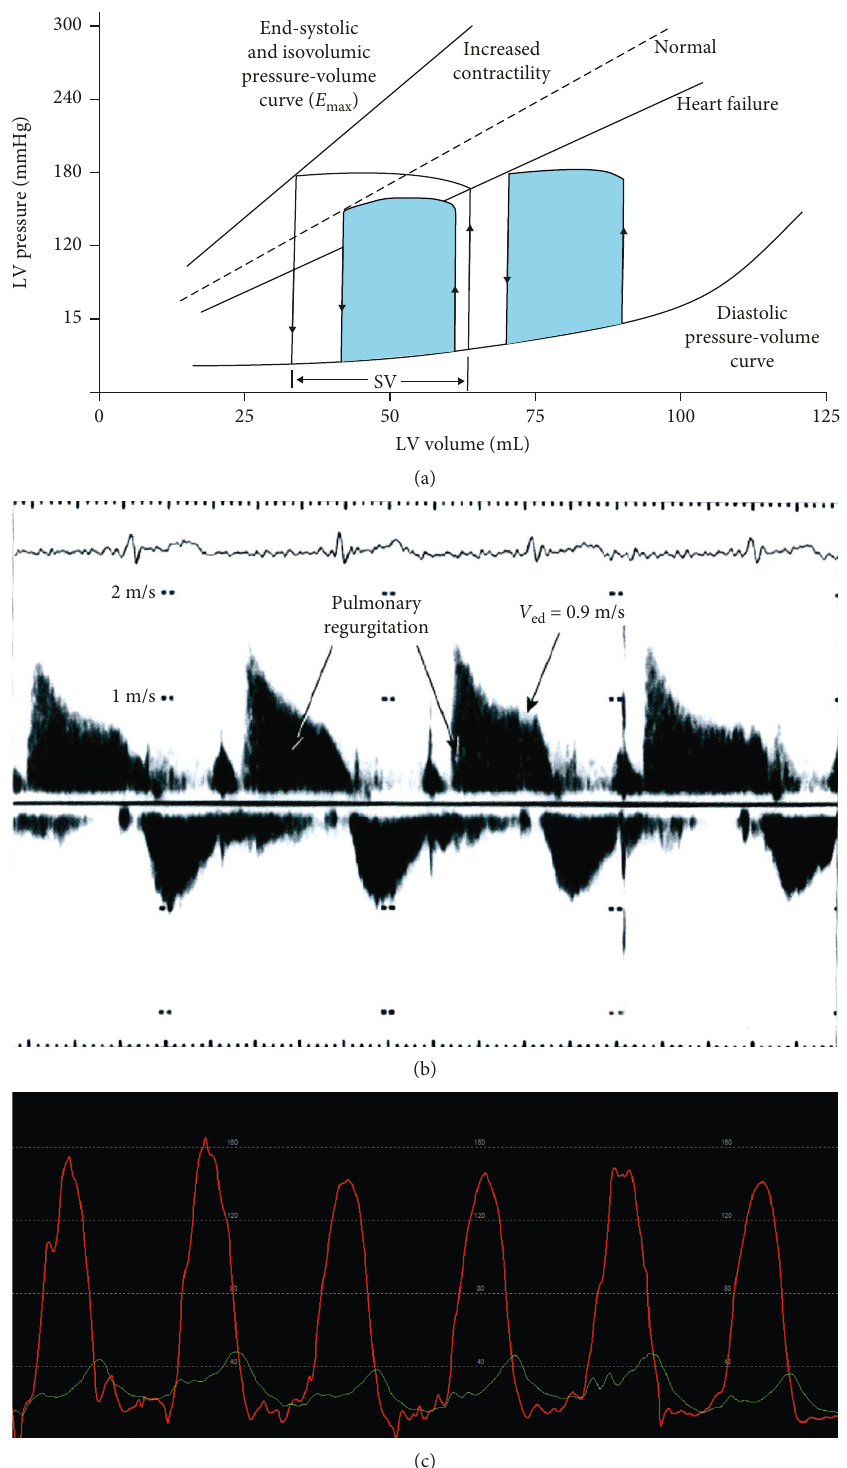
Figure 6: (a) Pathophysiology of dilated cardiomyopathy. The left ventricle reacts to an initial insult that decreases contractile force by increasing the end-diastolic volume ( x -axis). Initially, left ventricular end-diastolic pressure ( y -axis) remains low ( < 15mmHg) and the patient remains asymptomatic (AHA class B). However, if progressive dilatation occurs, the end-diastolic pressure begins to rise with resultant dyspnea (AHA class C). Further deterioration leads to a reduction in stroke volume and inability to maintain necessary end-organ perfusion (AHA class D). (a) is found in Mayo Board Review as Figure 91.7 (page 849). (b) Transthoracic echocardiogram to determine RVEDP. Typically obtained in the parasternal short-axis view at the cardiac base, continuous-wave Doppler of the pulmonary regurgitant signal coupled with right atrial pressure can estimate pulmonary artery end-diastolic pressure (PADP) via PADP � Δ P PVED + RAP. (b) is found in Mayo Board Review as Figure 79.7 (page 743). (c) Left ventricular (red) and pulmonary capillary wedge (PCWP) (green) tracings. Note the elevated left ventricular end-diastolic pressure (white arrow), elevated PCWP (green tracing) with prominent “v” wave (blue